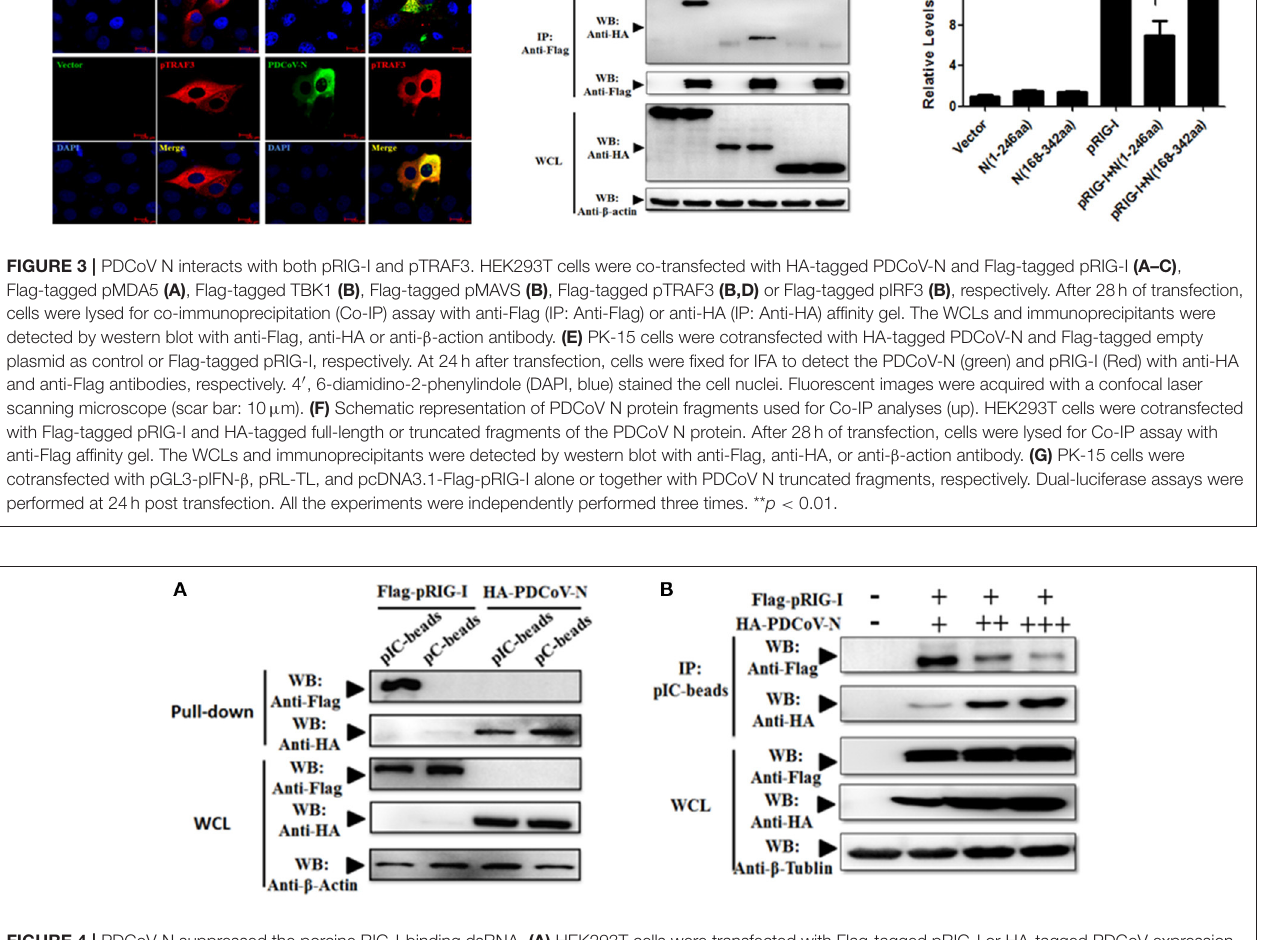
FIGURE 4 | PDCoV-N suppressed the porcine RIG-I-binding dsRNA. (A) HEK293T cells were transfected with Flag-tagged pRIG-I or HA-tagged PDCoV expression plasmid. Cells were lysed for Co-IP by poly(I:C) (pIC) or poly(C)(pC)-beads at 28h post-transfection. Western blot was used to detect the protein. (B) HEK293T cells were cotransfected with Flag-tagged pRIG-I with different dose HA-tagged PDCoV expression plasmid. After 28h of transfection, the cells were lysed for immunoprecipitation by poly(I:C)-beads. Western blot was used to detect the immunoprecipitants and WCLs